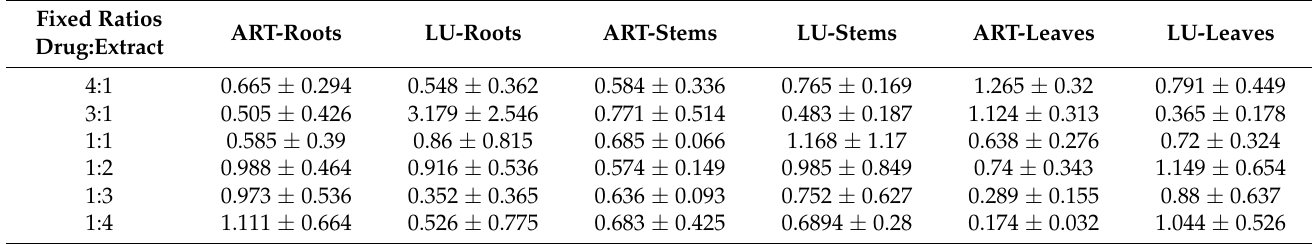
Table 4. Mean sum FIC 50 values for artemether and lumefantrine combinations with S. longipeduncu- lata against field isolates ex vivo.